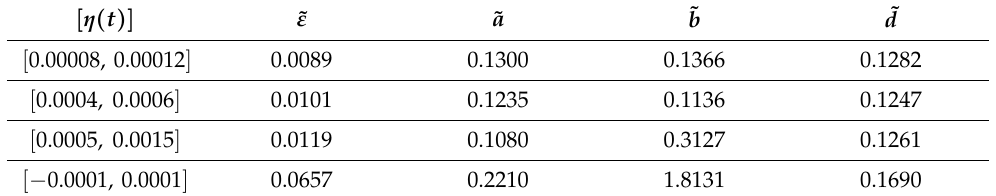
Table 2. Widths of estimated parameter intervals, obtained with the method presented in Section